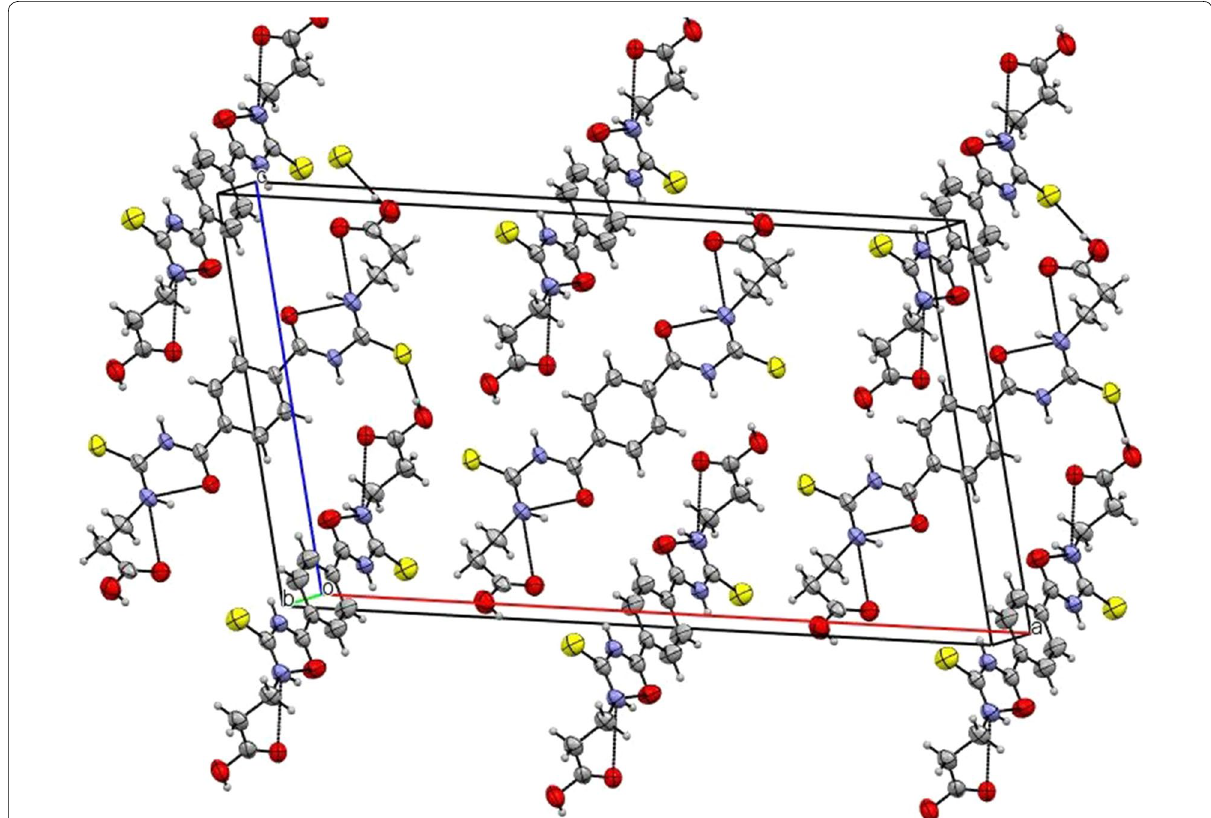
Fig. 2 Molecular packing of 1B viewed down the b axis. Dashed lines denote C–H….O, O–H….S and N–H….O hydrogen